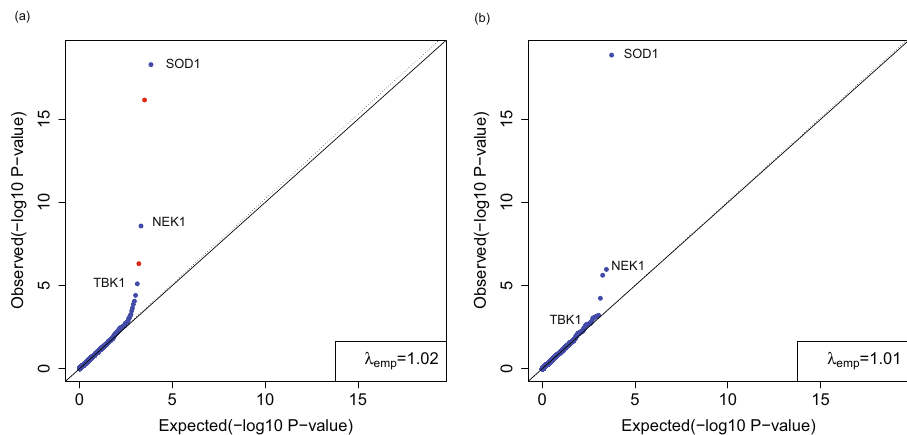
Fig. 7 Rare variant analysis of the Caucasian samples from the ALSDB data using summary counts for both cases and controls. a CoCoRV analysis with the two-sided Fisher ’ s exact test using control summary counts from the gnomAD non-Finnish Europeans. The red dots are false positives after a manual check on the variants contributing to the test statistics: the fi rst false positive is due to a large cluster of indels in the study-speci fi c case and control samples; the second is due to a variant with strong Hardy – Weinberg disequilibrium in both study-speci fi c cases and controls. b CoCoRV analysis with the two-sided Fisher ’ s exact test using control summary counts from the study-speci fi c 8186 Caucasian control samples. All P values are raw P values without multiple testing